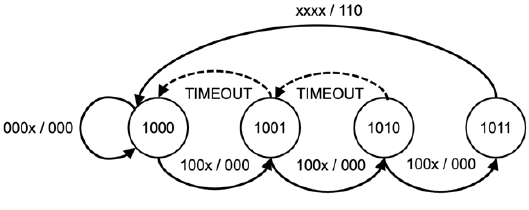
Figure 7. Association flood KCSM.